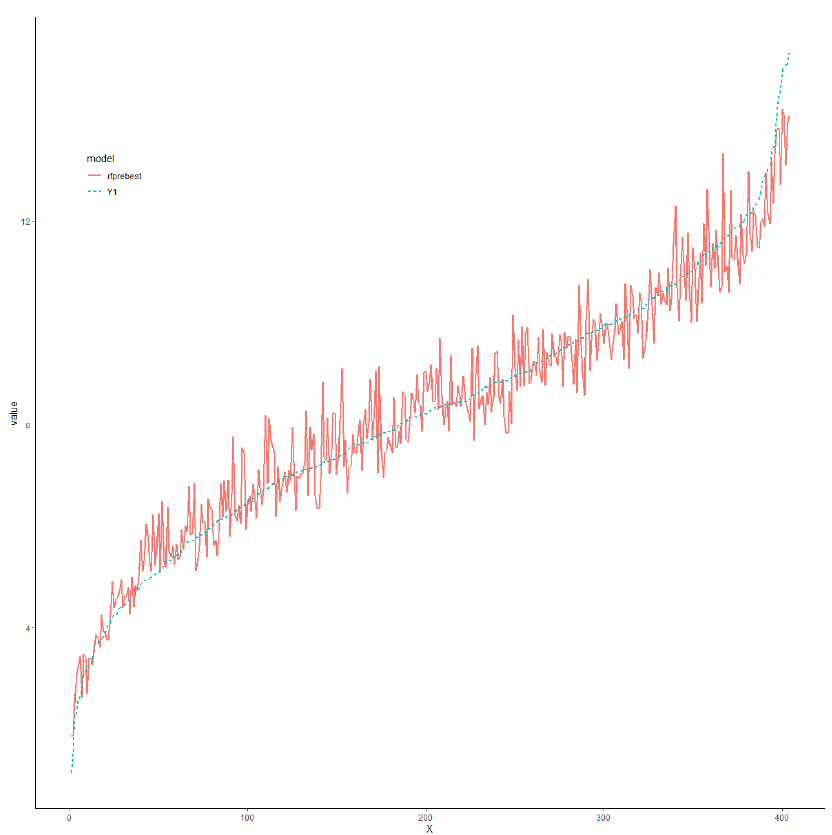
Figure 4. Random Forest. Results of model fitting.